Question: Express in one sentence what the figure is showing.
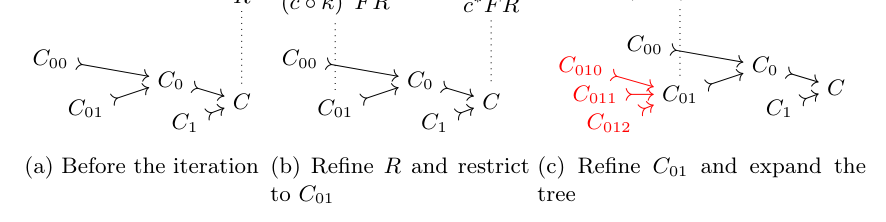
Answer: An iteration in our algorithm fPRH (Algo. 2). Fig. 1a shows an equivalence relation R over C, and the corresponding partitioning C00, C01, C1 ↣C of the state space C. (The history of refinement is recorded as a tree; this is important for complexity analysis.) In Fig. 1b, the equivalence relation R is refined into c∗FR along the one-step transition of the system dynamics c, and is further restricted to the partition C01. In Fig. 1c, the resulting equivalence relation (c ◦κ)∗FR over C01 yields a partitioning of C01, expanding the tree.